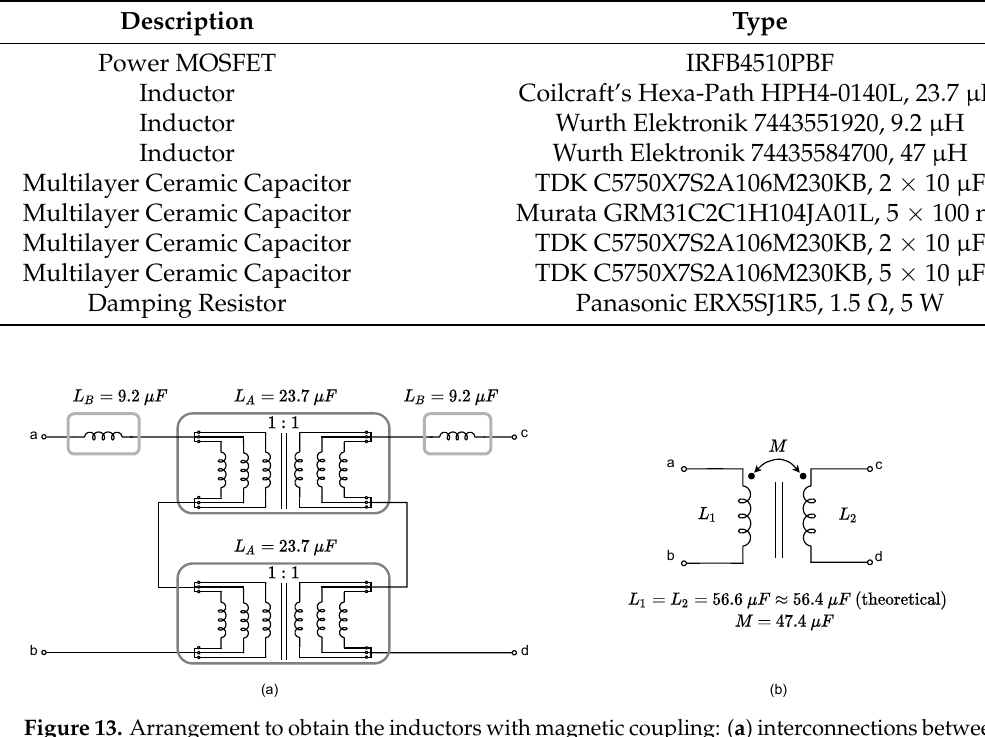
Table 9. Components description of the reconfigurable power converter.